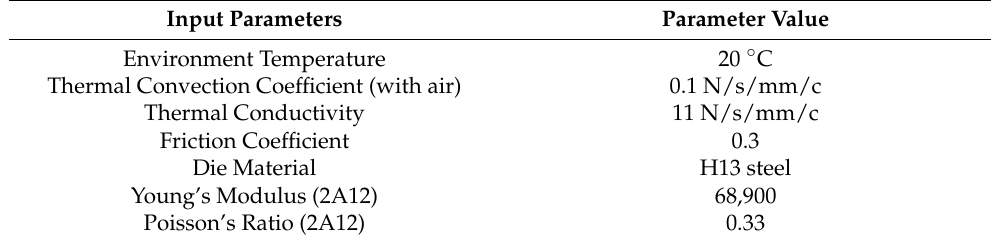
Table 5. Deform Analog Input Parameters.